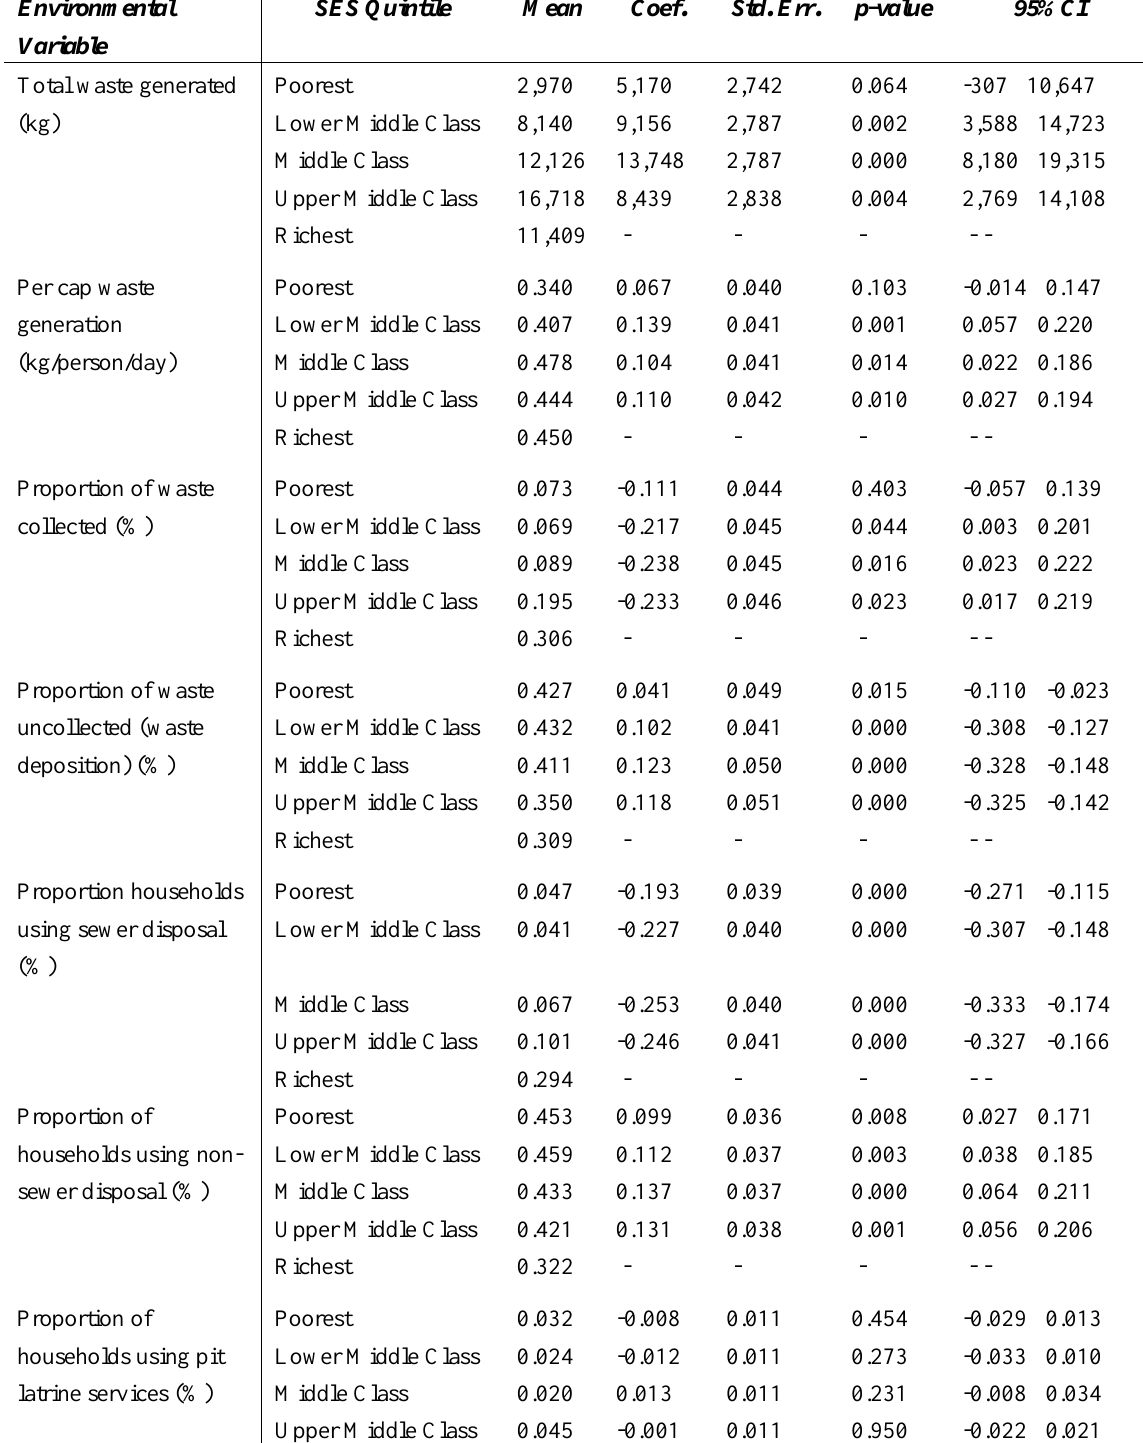
Table 1. Socioeconomic classes and environmental health